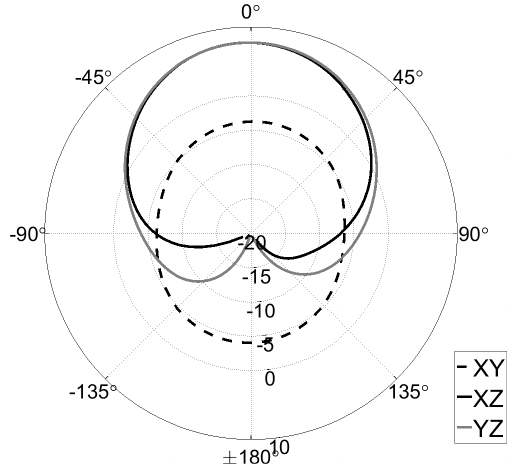
Figure 9. Measured radiation pattern of the designed